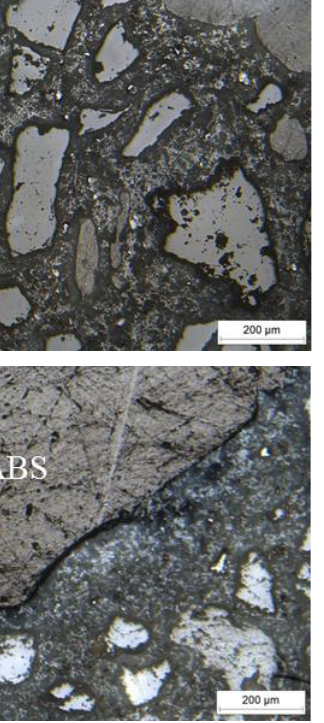
Figure A2. Example of optical observations.